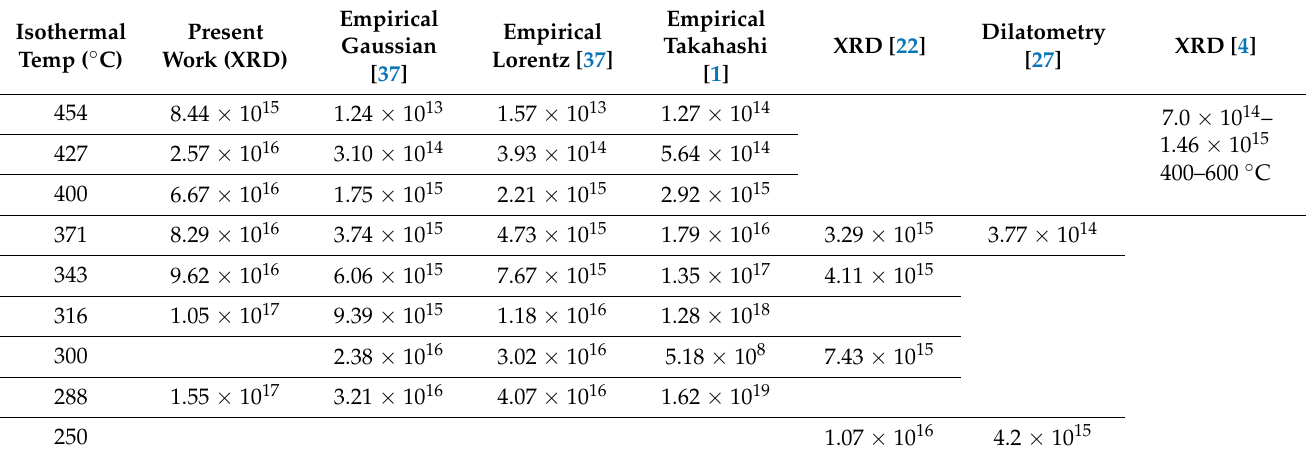
Table 2. Comparison of the dislocation density ρ (m − 2 ) calculated using different